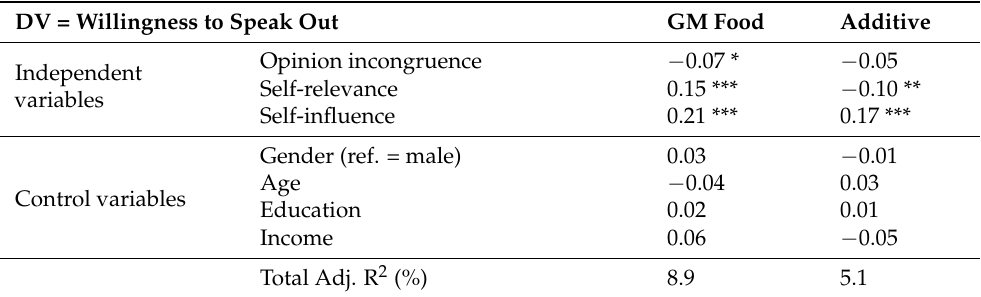
Table 4. Factors influencing willingness to speak out about food safety issues on social media. DV = Willingness to Speak Out GM Food Additive